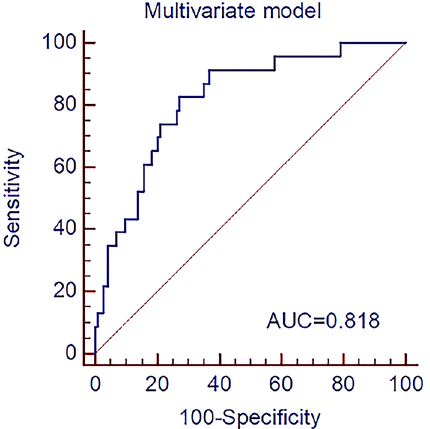
Figure 3. Receiver operating characteristic curve of multivariate model based on binomial logistic regression analysis for predicting human epidermal growth factor receptor 2 status of gastric cancer in the primary cohort. The AUC of the multivariate model was 0.818. AUC area under the receiver operating characteristic curve.